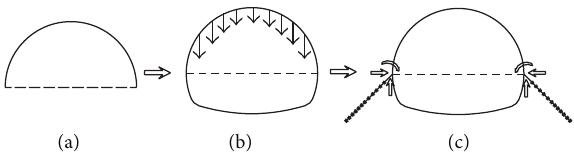
Figure 12: Mechanism of the feet-lock bolt (after